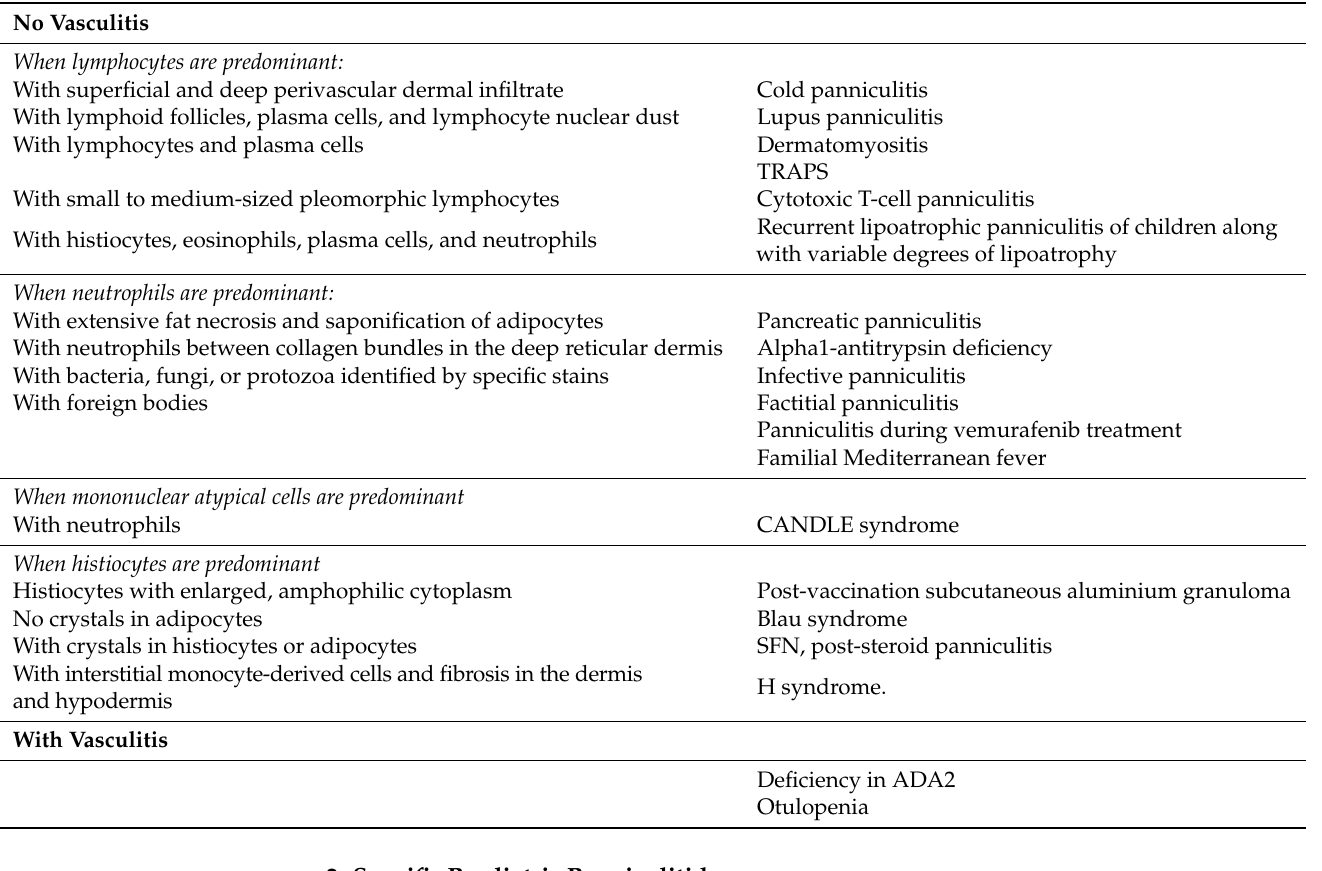
Table 1. The histopathologic classification of lobular panniculitis in